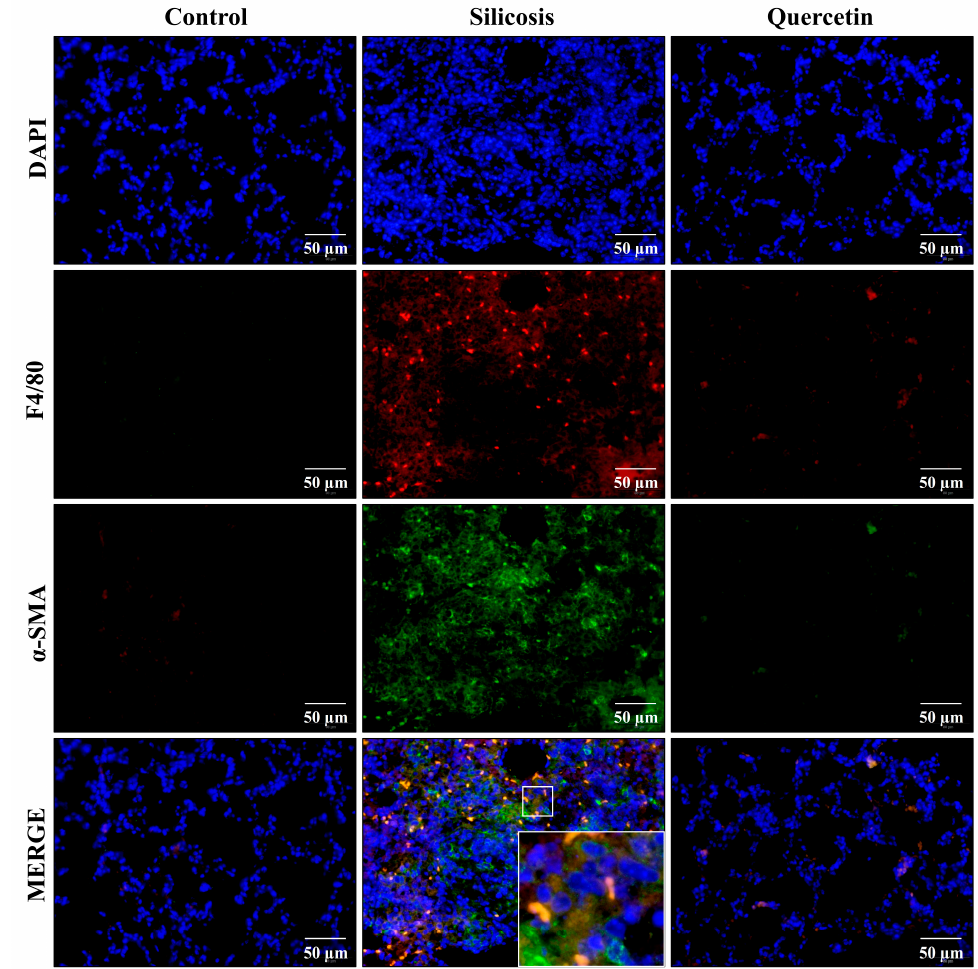
Figure 6. The expressions of F4/80 and α -SMA in the lungs, measured by immuno fl uorescent staining (scale bar = 50 µm). Blue, DAPI; red, F4/80; green, α -SMA.